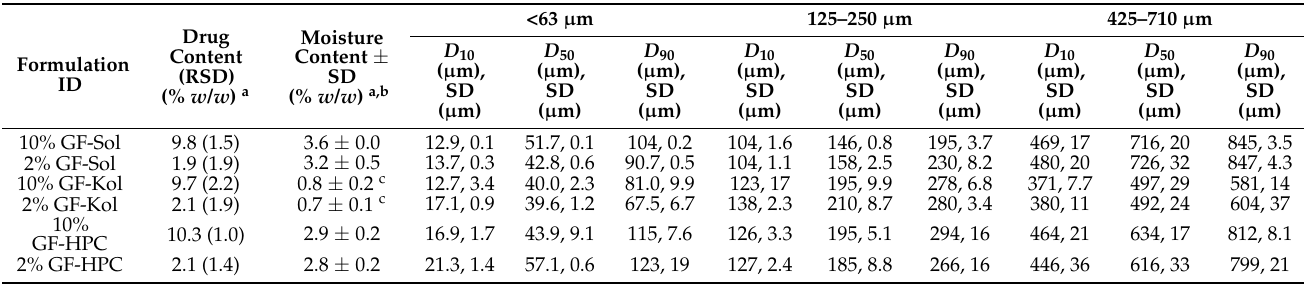
Table 3. Drug–moisture content of the extrudates and characteristic particle sizes of three sieve fractions obtained from the milling–sieving of the